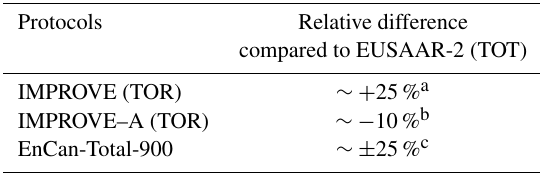
Table 1. Overview of reported differences between EC calculated with other protocols minus the EC calculated with the EUSAAR-2